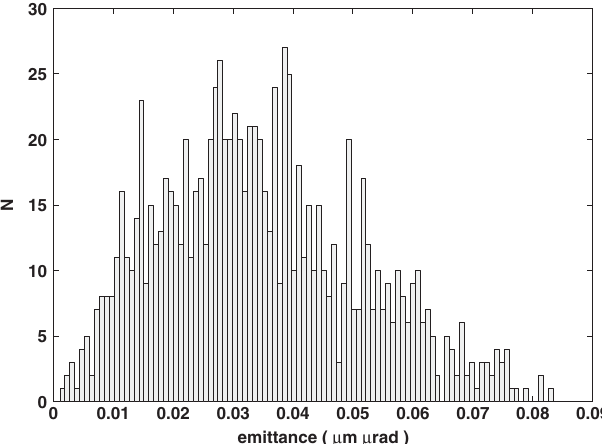
FIG. 3. Example of a least-squares emittance fit with the Cholesky decomposition (35% error level, 4D ILC optics). The amount of statistics with the Cholesky method is about 3 times larger. It is however more biased. The true emittance is 0 : 079 (cid:3) m (cid:8) (cid:3) rad .